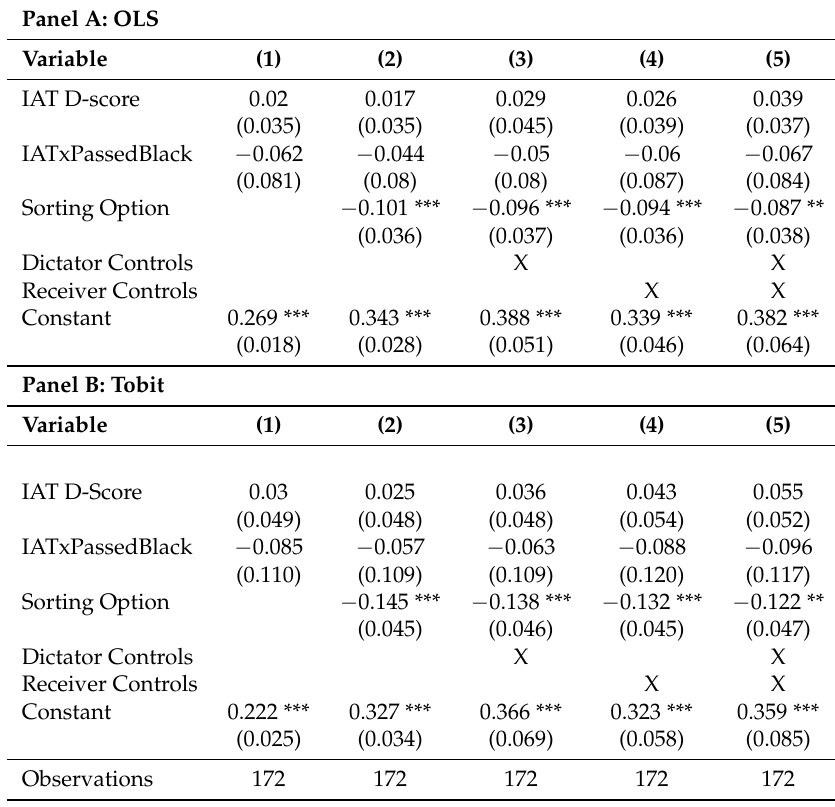
Table 7. The IAT’s effect on percent